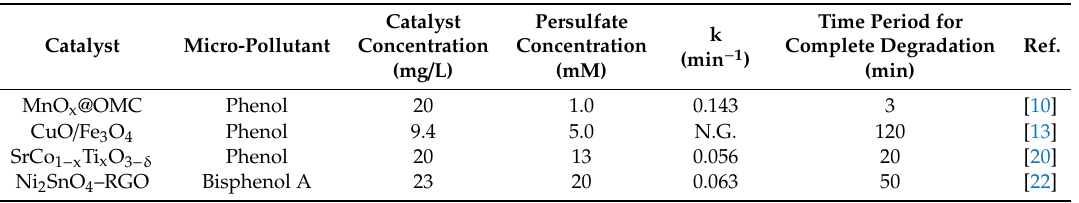
Table 2. Persulfate activation by heterogeneous systems. N.G.: not given.